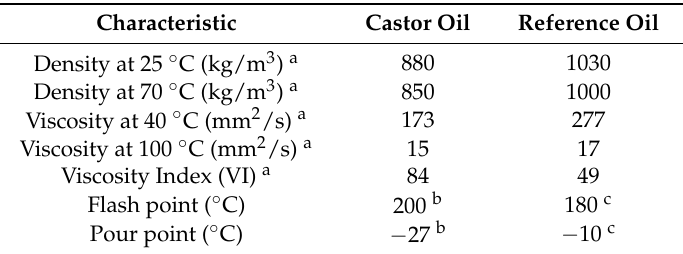
Table 1. Characteristics and properties of